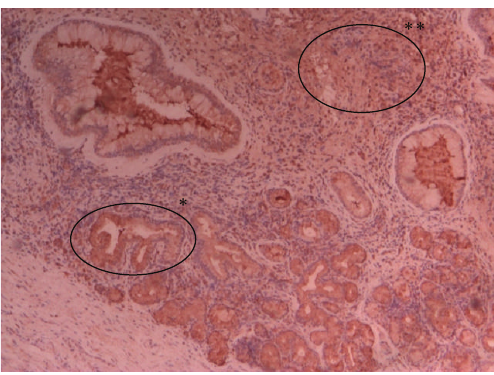
Figure2:Nasalmucosa:PLUNCpositive(++)IHC40x.++PLUNC antibodies positivity in epithelium ( ∗ ) and in stroma ( ∗∗ ).